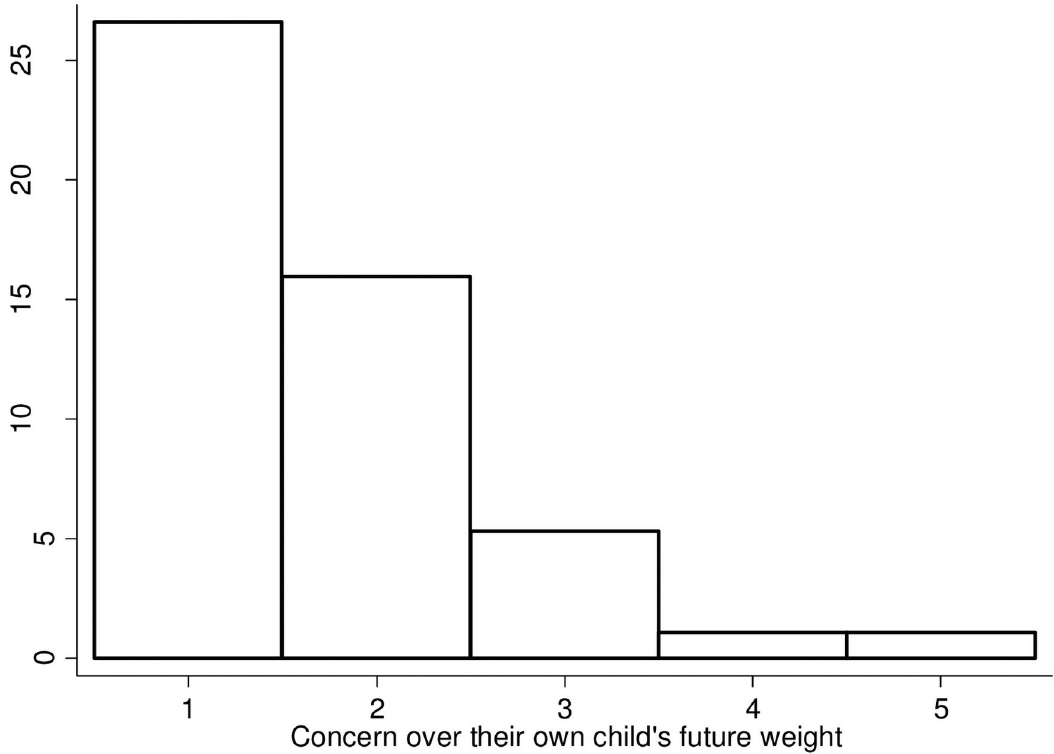
Fig 3. Visual depiction of parental concern in overweight children. This bar chart shows the level of concern the 47 parents of overweight children have regarding their child’s future weight status. The concern level ranges from unconcerned (1) to very concerned (5). Most parents were either unconcerned (1) or a little concerned (2) regarding the future weight status of their already overweight